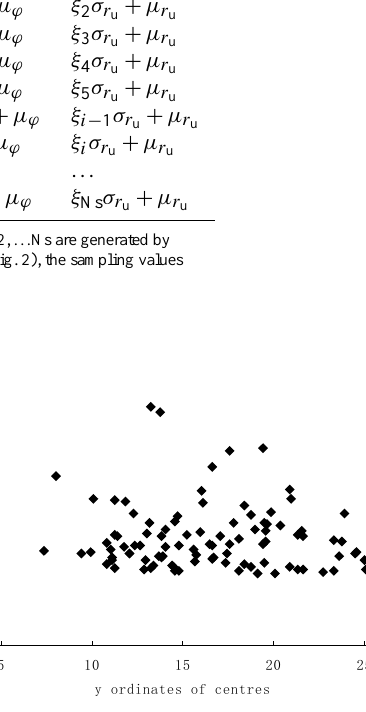
Figure 5. 100 centres of randomly generated trial slip